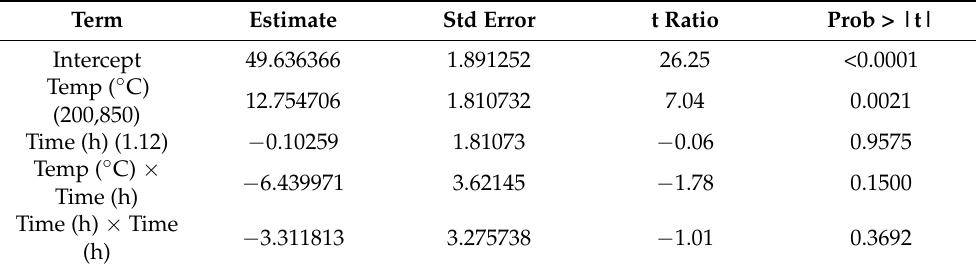
Table 8. Parameter estimates (Na-based